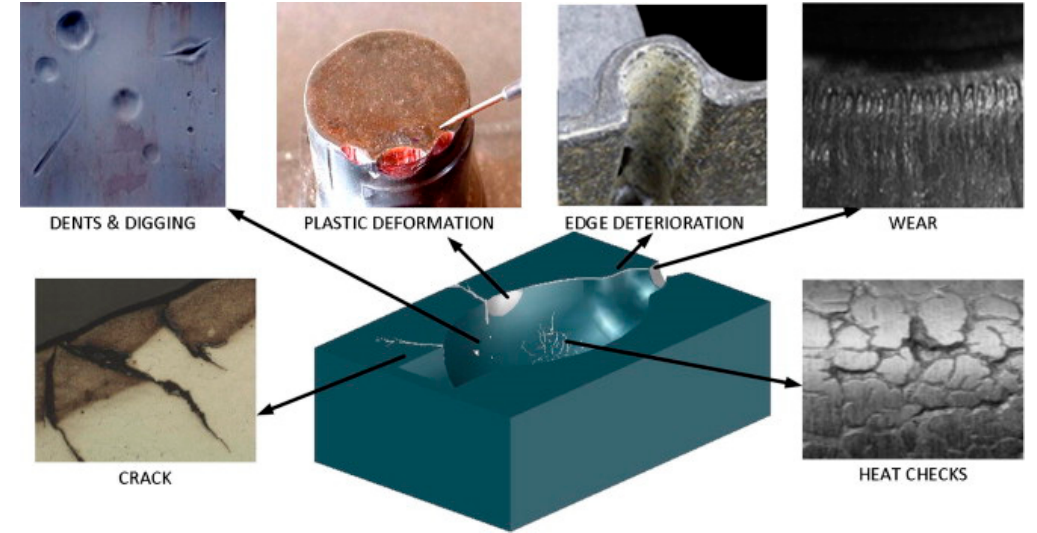
Figure 7. Different types of defects in dies and molds [94]. Figure 7. Di ff erent types of defects in dies and molds